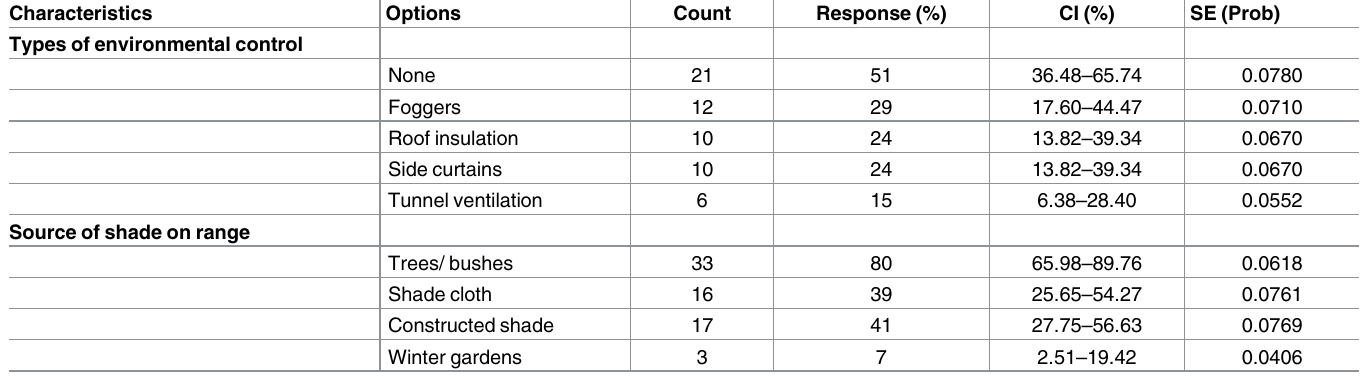
Table 4. Environmental control on respondent